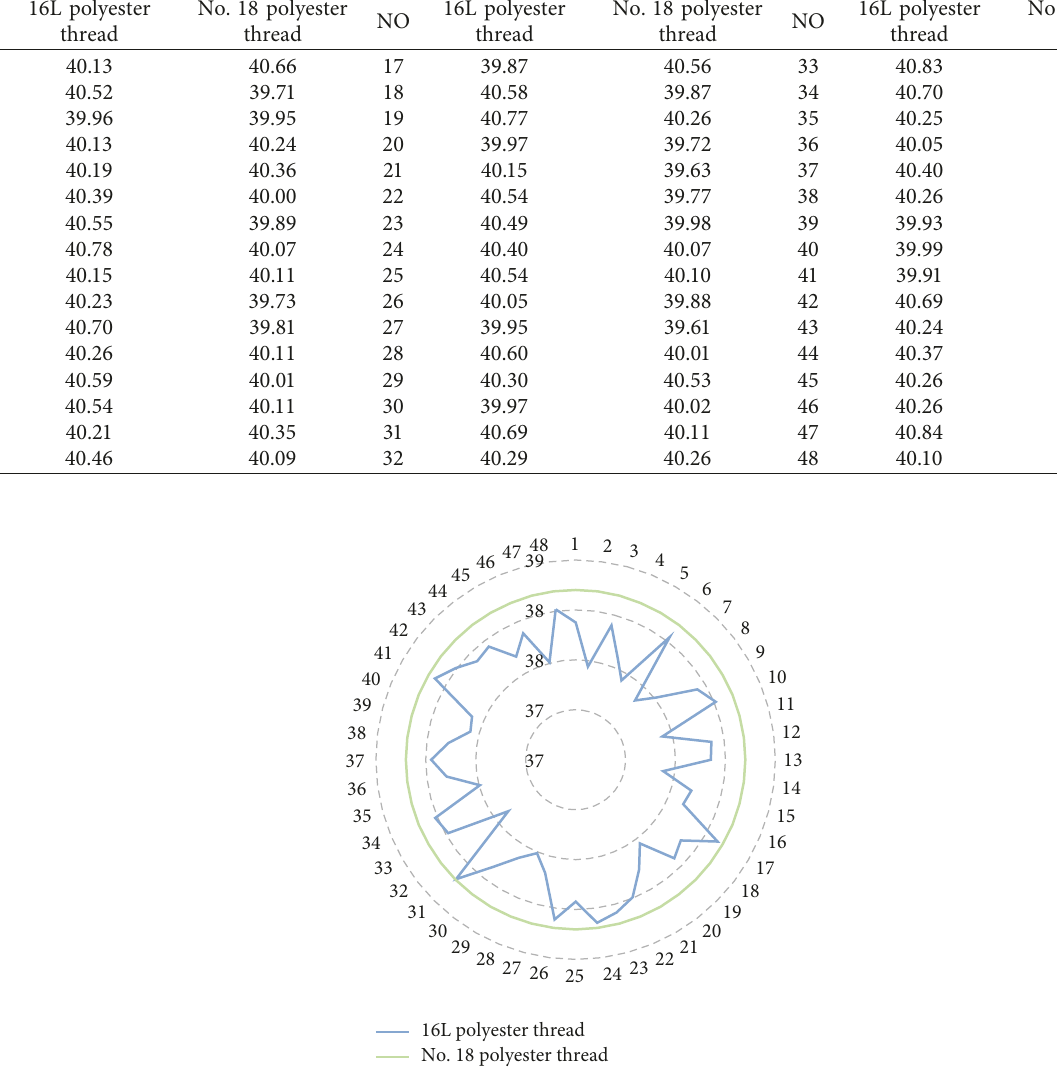
Figure 8: The statistical diagram of the vibration frequency of the racket acceleration and impact of different string diameter